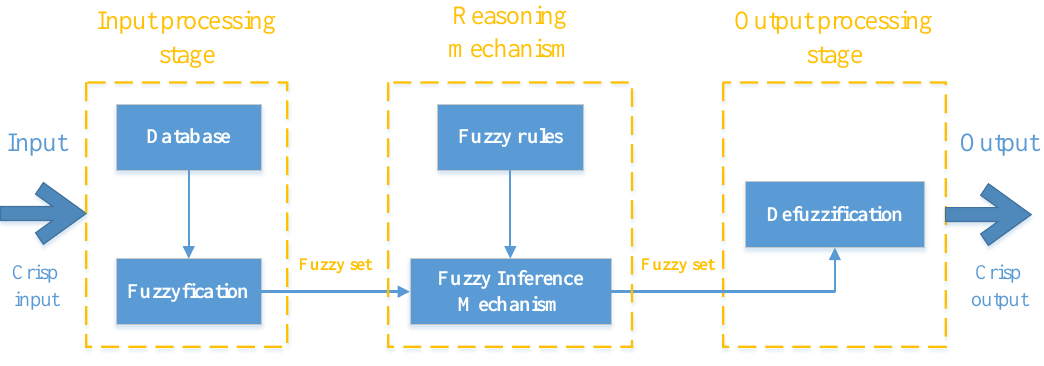
Figure 3. Type-I fuzzy inference system block diagram adapted from [34].